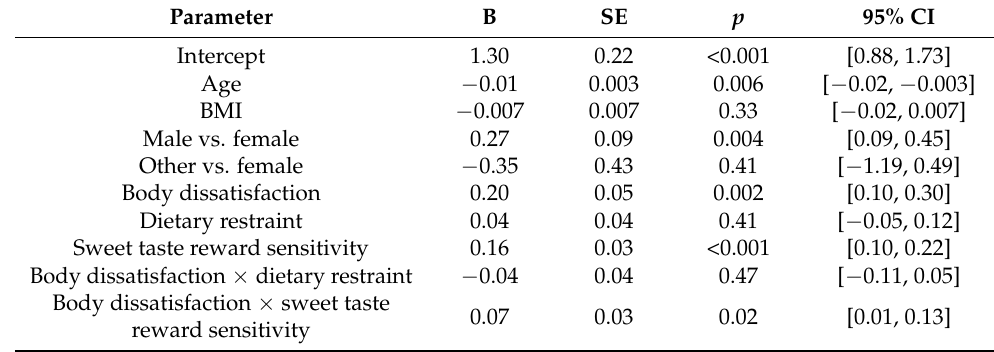
Table 2. Linear Regression Model of Binge Eating on Body Dissatisfaction, Dietary Restraint, and Sweet Taste Reward